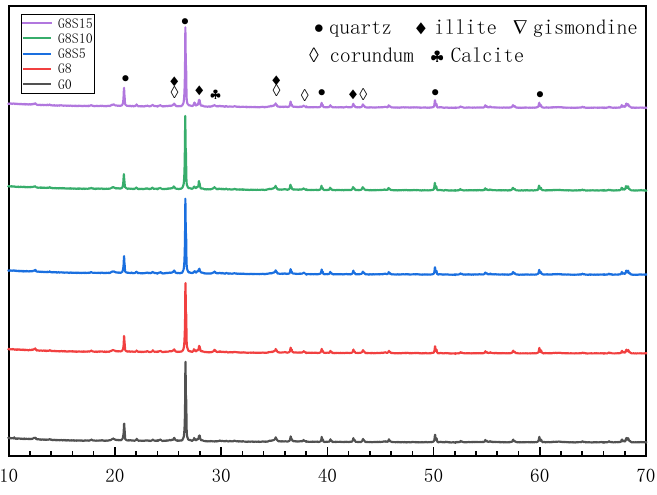
Figure 7. X - ray diffraction patterns of G0, G8, G8S5, G8S10 and G8S15. Figure 7. X-ray diffraction patterns of G0, G8, G8S5, G8S10 and